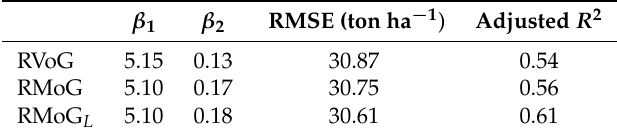
Table 3. Coefficients of the fitted exponential model (within 95% confidence interval).